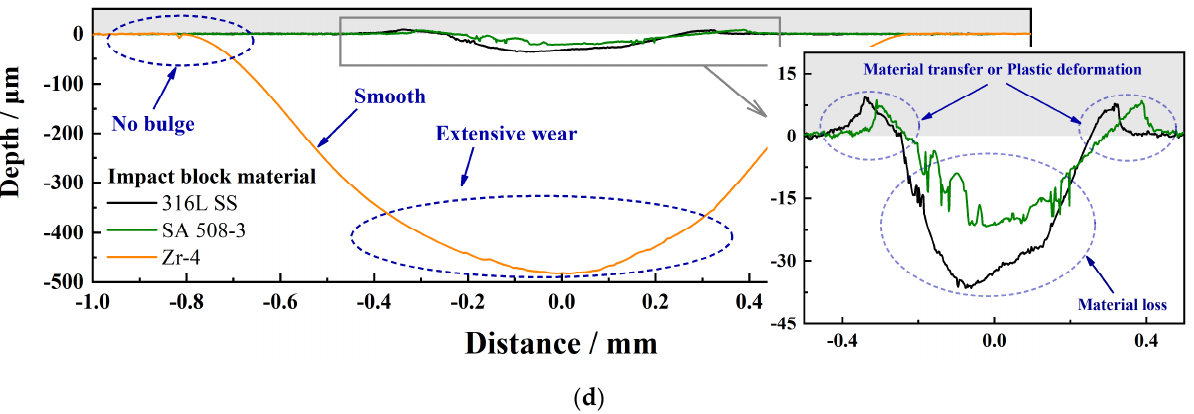
Figure 10. OM images and profile micrographs of wear scar after Zr−4 alloy tube impacted 500,000 times: ( a )316L SS, ( b ) SA 508−3, ( c ) Zr − 4, ( d ) sectional profiles.